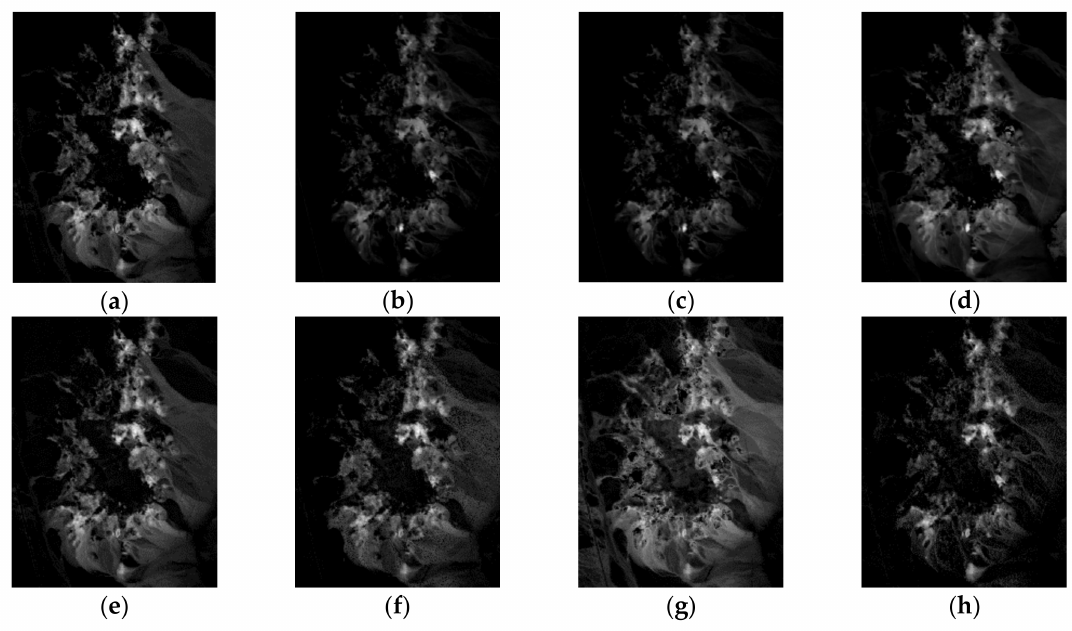
Figure 11. Alunite: ( a ) VCA, ( b ) N-FINDR, ( c ) SGA, ( d ) C-NMF, ( e ) MVC-NMF, ( f ) ICE, ( g ) SPICE, ( h ) SPEEVD.